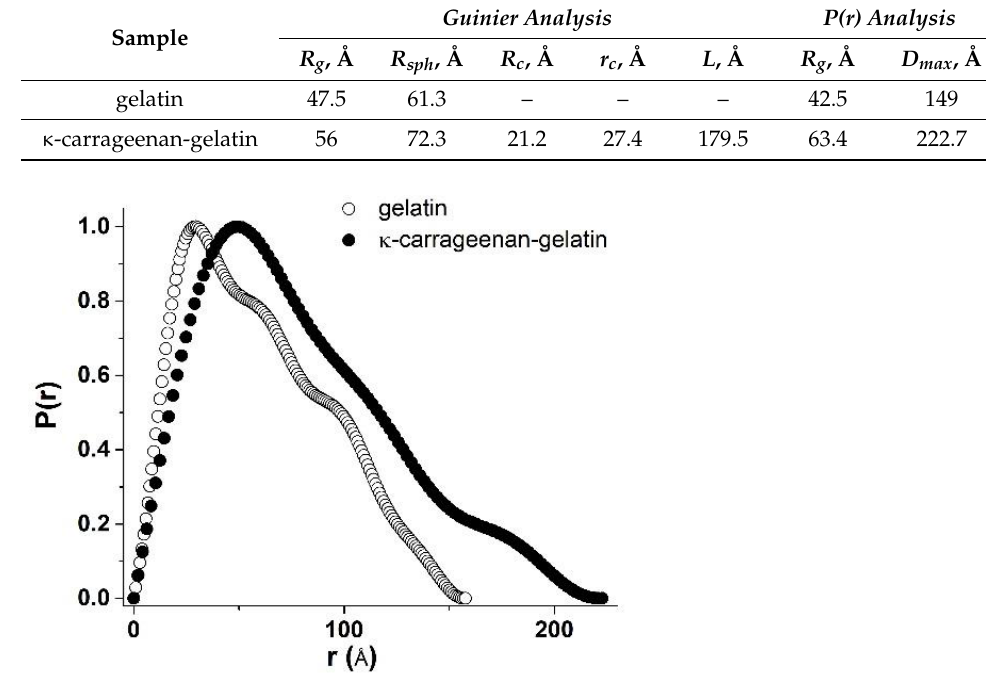
Figure 3. Normalized distance distribution functions P(r) derived from SAXS data for gelatin (open symbols) and κ -carrageenan–gelatin (filled symbols) gels. Table 1. Structural parameters for hydrogels at 14 °C.